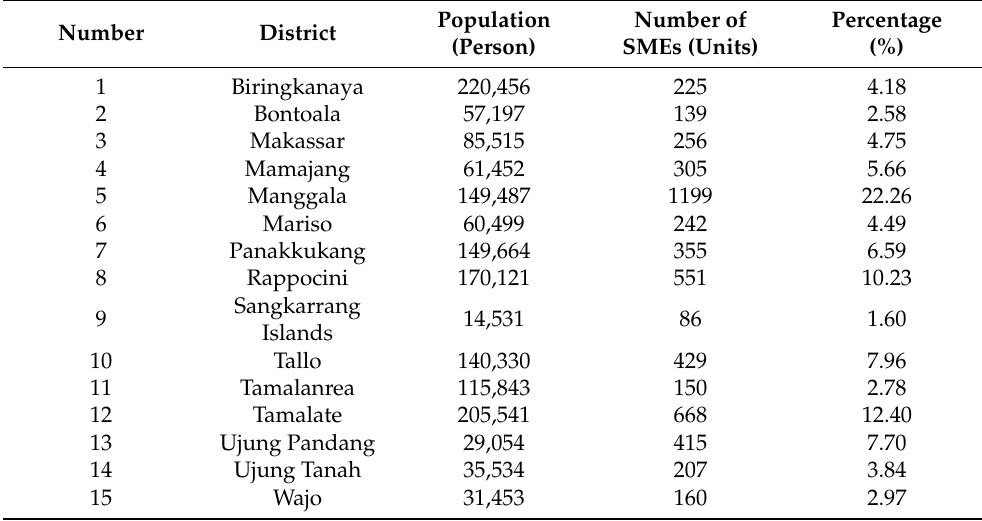
Table 1. Numbers of small and medium enterprises (SMEs) by district in